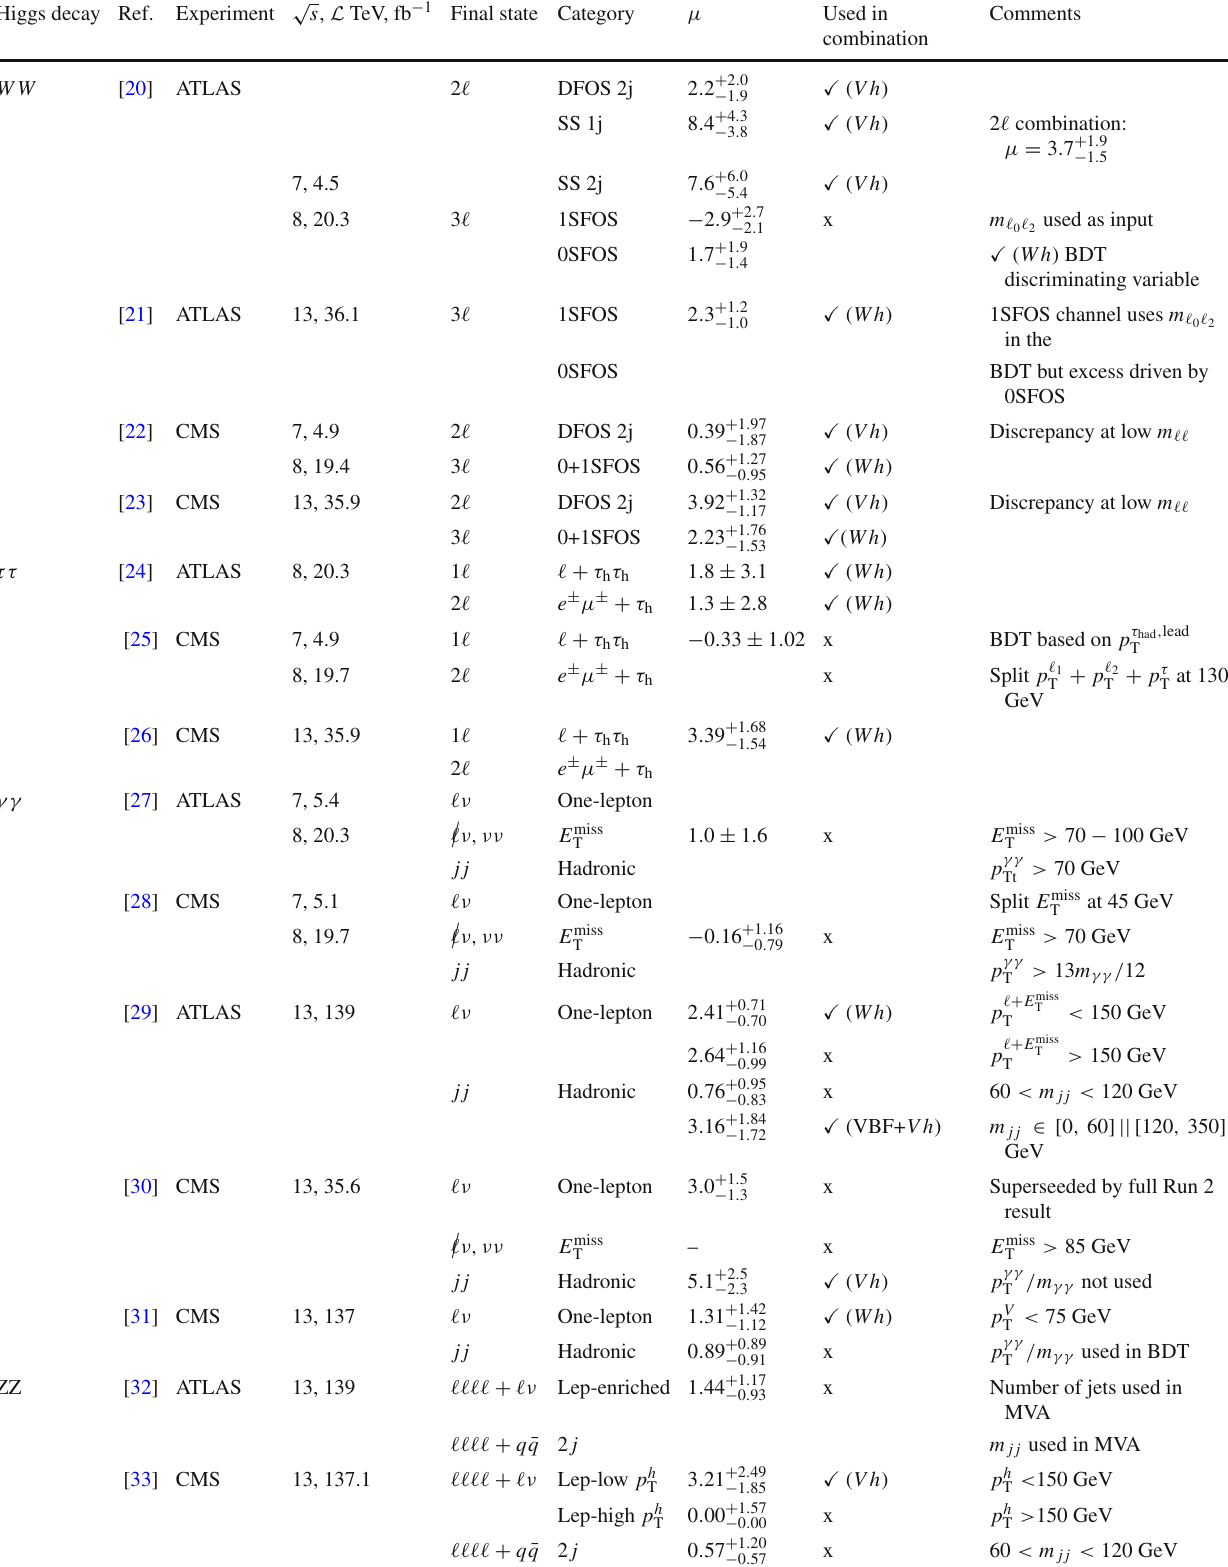
Table 1 Summary of ATLAS and CMS Vh results. The “–” symbol indicates that the signal strength result is not provided for that specific category √ s , L TeV, fb − 1 Final state Higgs decay Ref. Experiment